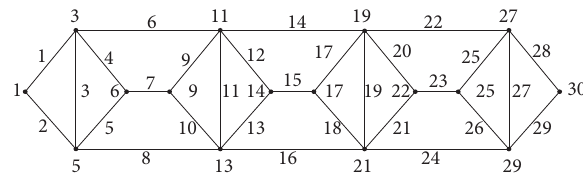
Figure 16: A classical mean labeling of Dl